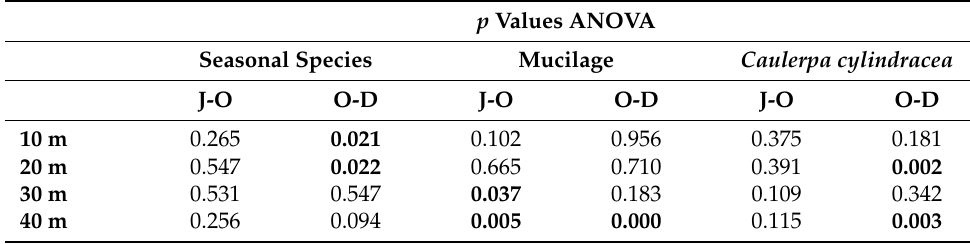
Table 4. The p values of Student’s t -test, applied to analyse the differences between time trajectories (J-O: June to October; O-D: October to December) of the original data matrix and the simulated ones at the four depths investigated. Significant differences are in bold. p Values ANOVA Seasonal Species Mucilage Caulerpa cylindracea J-O O-D J-O O-D J-O